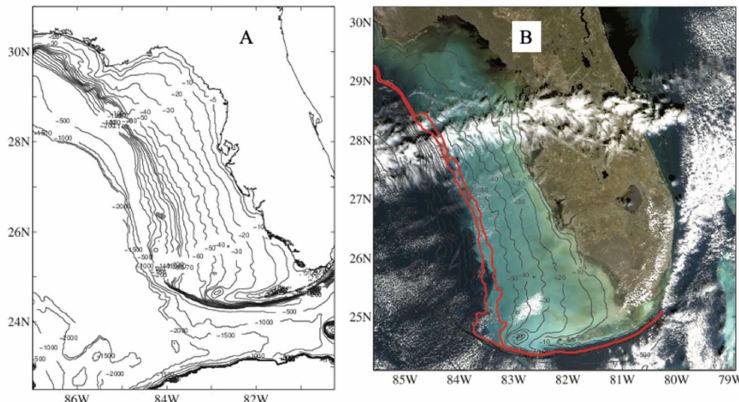
Figure 6. ( A ) Contour plot of WFS Digital Bathymetric Data Base (DBDB2) with 10-m contour intervals out to the 100-m contour and ( B ) the TC image for 23 December (VIIRS, SNPP) with bathymetry contours overlaid, where the 60 and 70-m contours are shown in red and appear to delimit the seaward extent of the apparent surface water